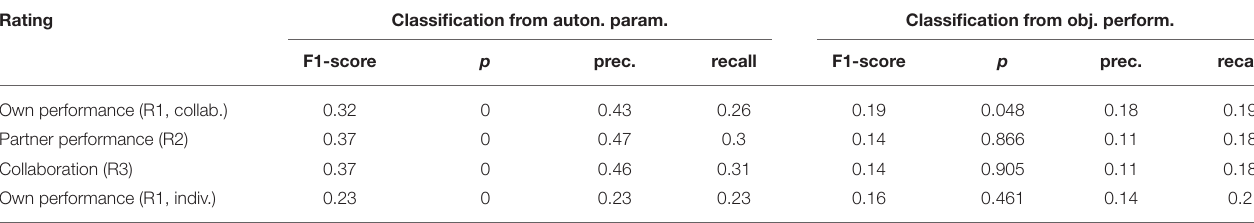
TABLE 5 | F1-scores, precision, and recall from leave-one-subject-out cross-validation and p -values from a randomization test. Rating Classification from auton. param. Classification from obj. perform. F1-score p prec. recall F1-score p prec. recall Own performance (R1, collab.) 0.22 0.001 Partner performance (R2) 0.23 0 Collaboration (R3) 0.21 0.008 Own performance (R1, indiv.)